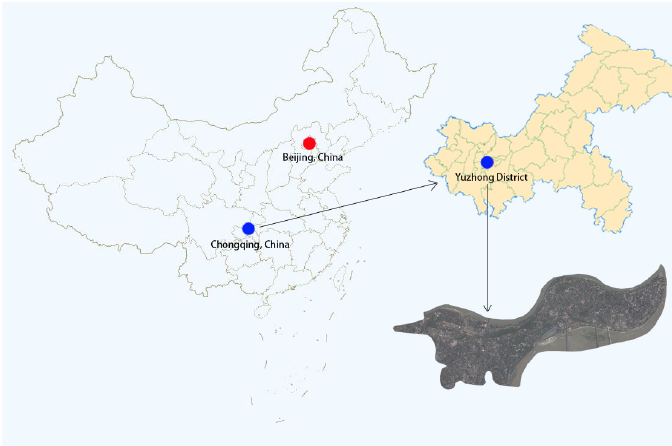
Figure 3. Location analysis of Yuzhong District, Chongqing, China.